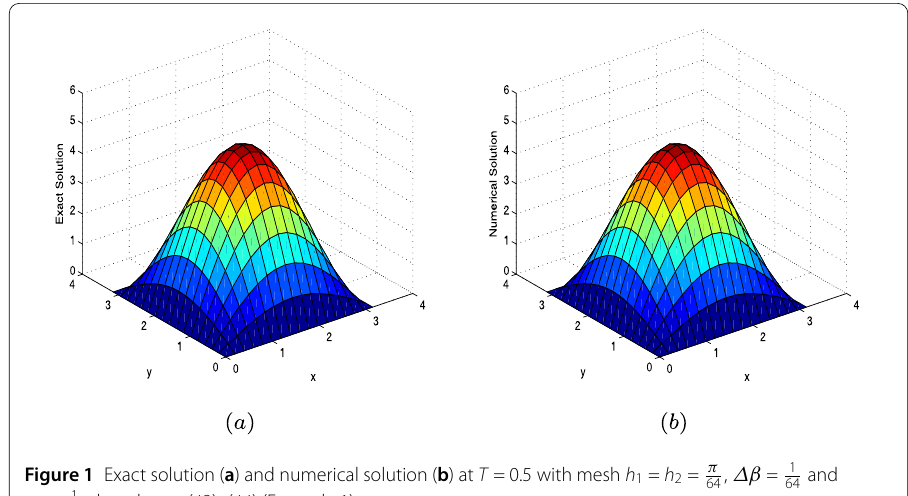
Figure 1 Exact solution ( a ) and numerical solution ( b ) at T = 0.5 with mesh h 1 = h 2 = π τ = 1 by scheme (43)–(44) (Example 1) 4096